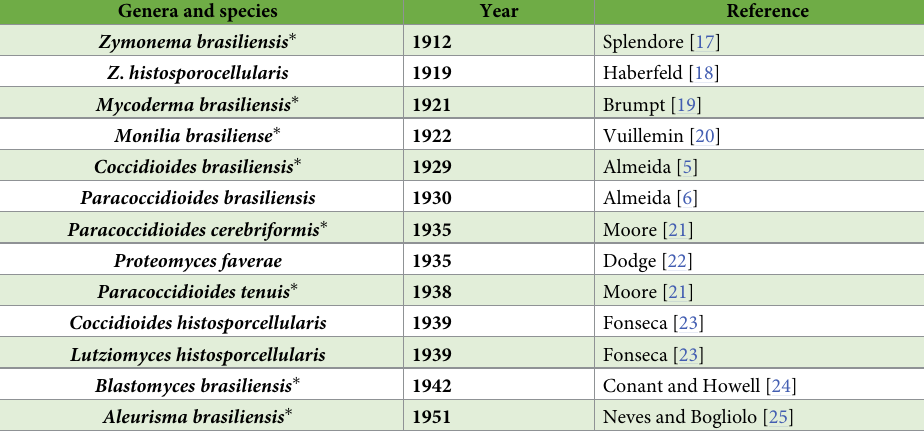
Table 1. Paracoccidioides brasiliensis binomials.